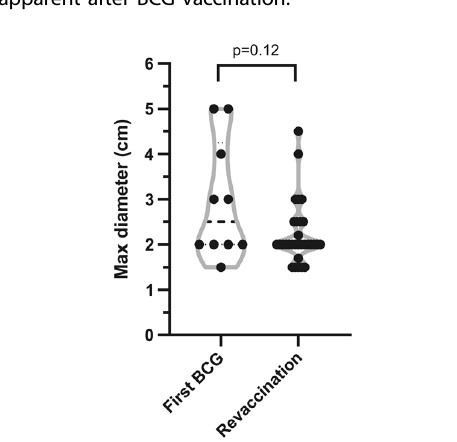
Fig. 2 Injection site abscess onset. Time at which injection site abscess apparent after BCG vaccination.